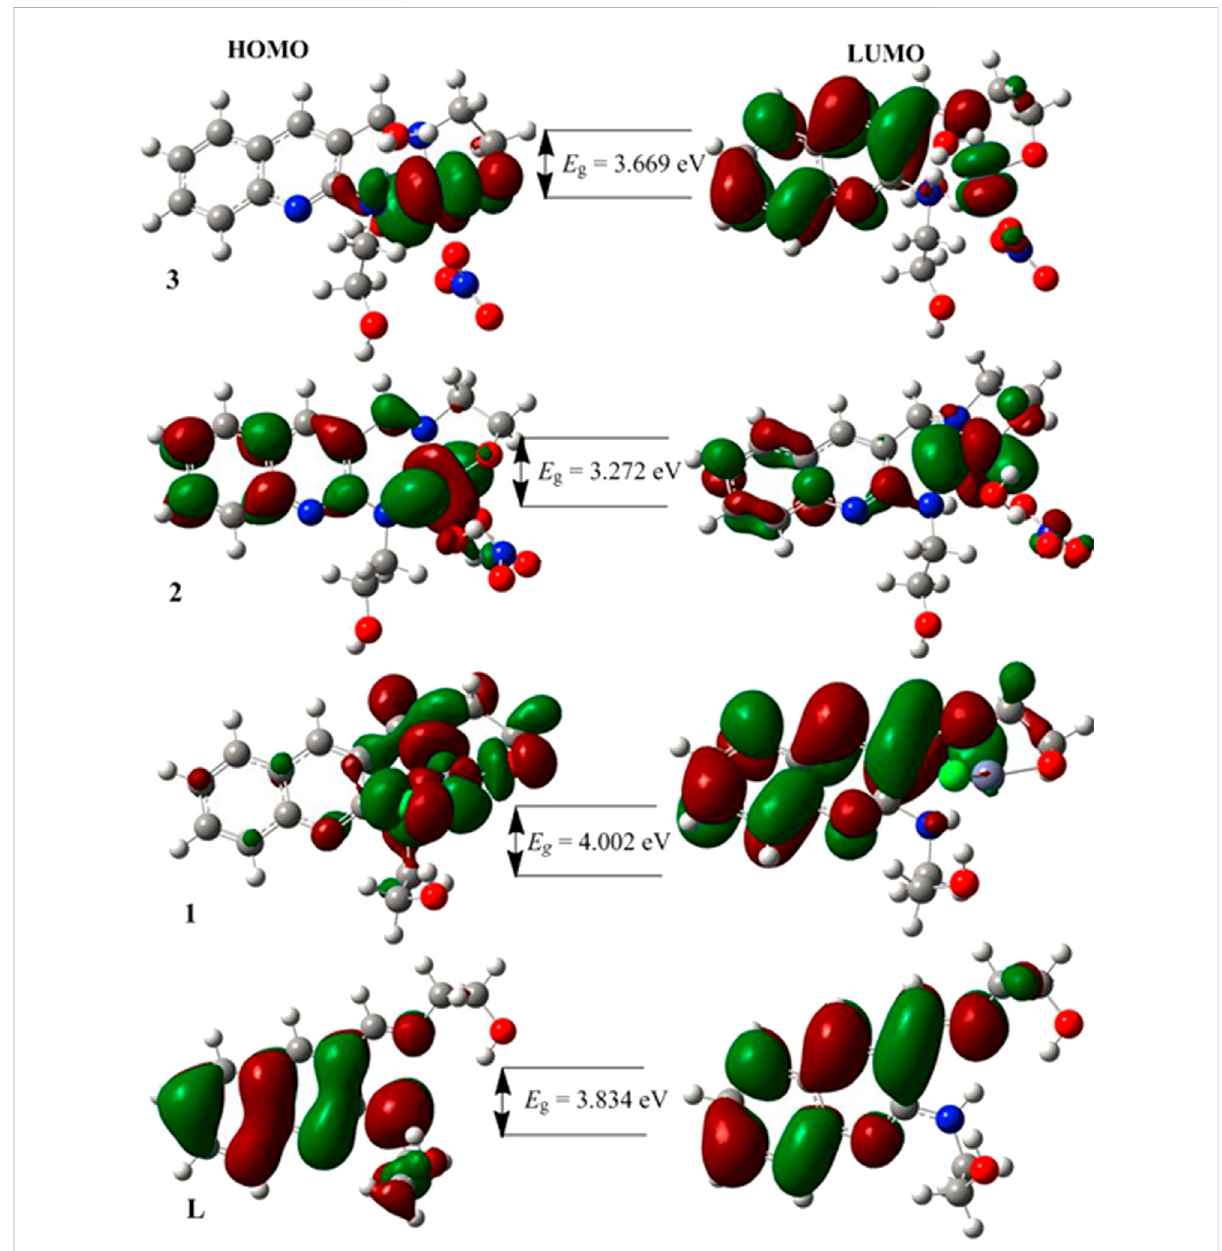
FIGURE 2 The frontier molecular orbitals (HOMO and LUMO) of the ligand and its metal complexes 1 – 3